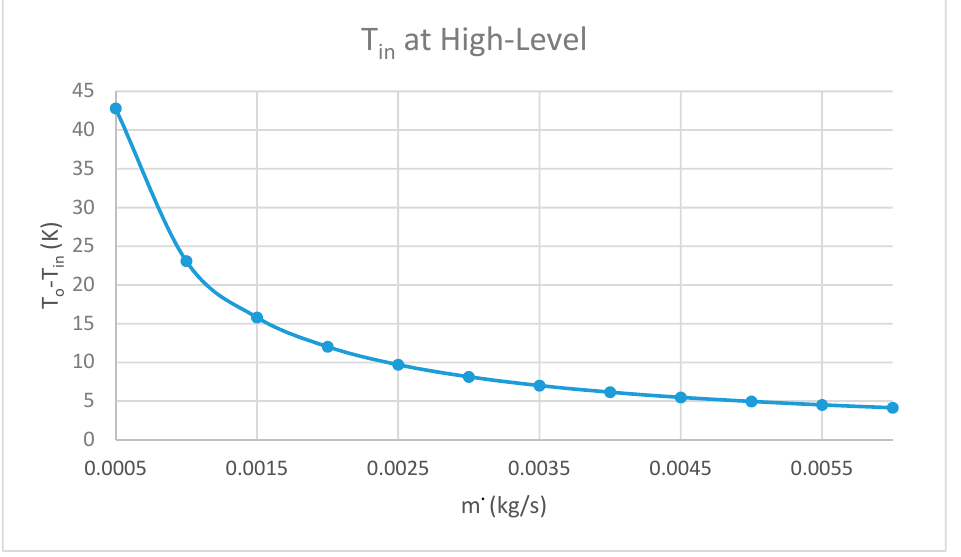
Figure 10. The effect of inlet flowrate on (cid:2015) (cid:3047)(cid:3035) at Low-Level inlet temperature. Figure 11 illustrates the effect of inlet flowrate on thermal efficiency ( (cid:2015) (cid:3047)(cid:3035) ) at High-Level inlet temperature. (cid:2015) (cid:3047)(cid:3035) increased with the increase in mass flowrate but lower than the one at Low-Level inlet temperature due to the increase in temperature difference between the water inside the pipe and the ambient temperature which increased the losses. A maximum (cid:2015) (cid:3047)(cid:3035) of 64.5% occurred at the